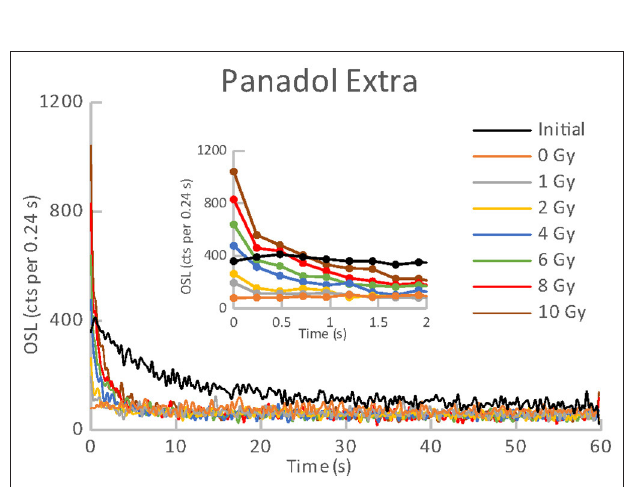
FIGURE 4 | OSL curves for the initial readout and subsequent post-irradiations readouts of an aliquot of